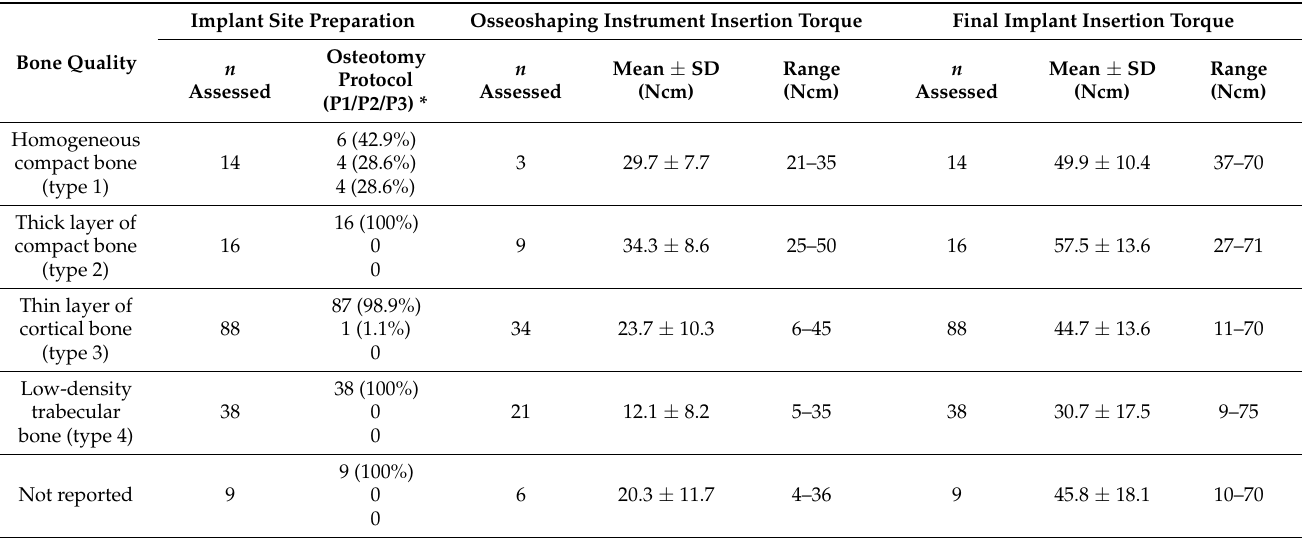
Table 2. Selected surgical characteristics according to bone